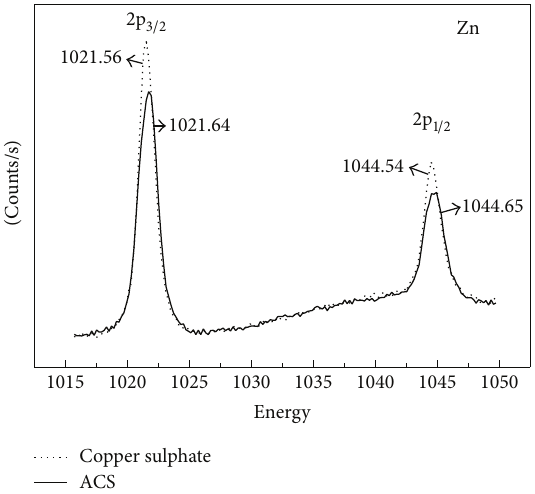
Figure 10: 2p spectra of Zn on sphalerite in the presence of different activator and collector butyl xanthate.